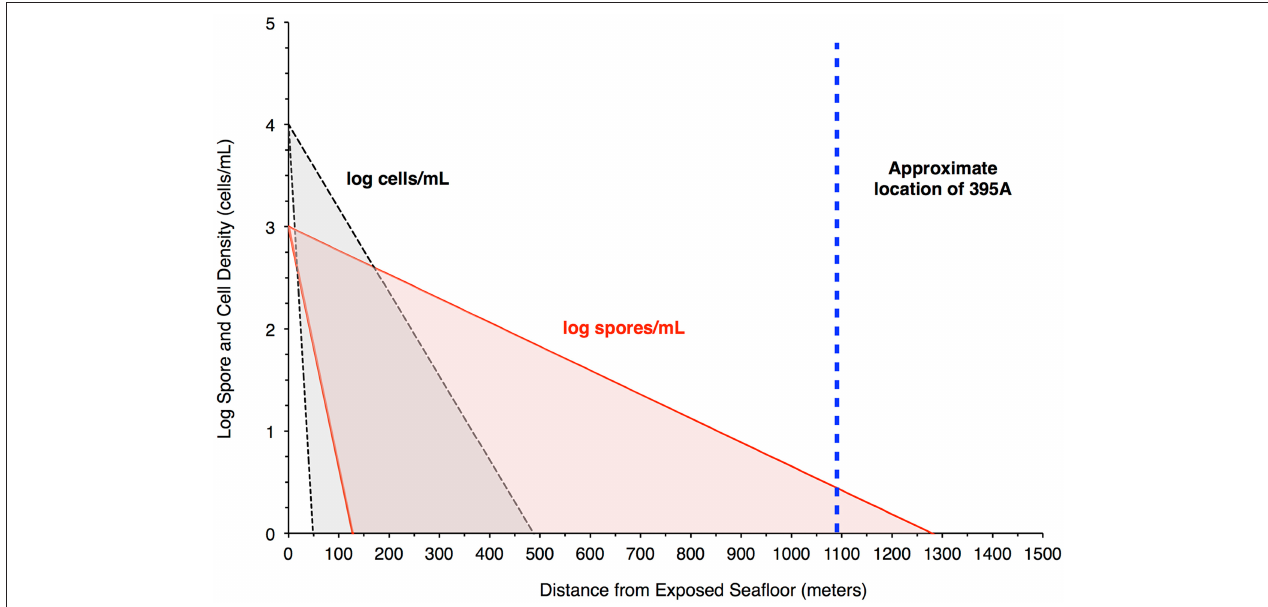
FIGURE 4 | Filtration of bacteria in the crust would produce higher spore densities in pore water 1 Km from a putative recharge zone. The plot shows results from a model that attempts to assess the likelihood of seeing a greater concentration of spores relative to bacteria in pore water at the location of Hole 395A. The red shaded area bordered by the red solid lines indicates the concentration of spores in pore fluids, while the gray shaded area bordered by the black hashed lines indicates the concentration of cells in pore fluids. The blue, hashed line is the location of Hole 395A relative to the exposed ocean crust southwest of North Pond, which serves as a putative recharge zone for purposes of modeling. The model suggests that spore densities will drop off less rapidly than cell densities in the pore fluids.